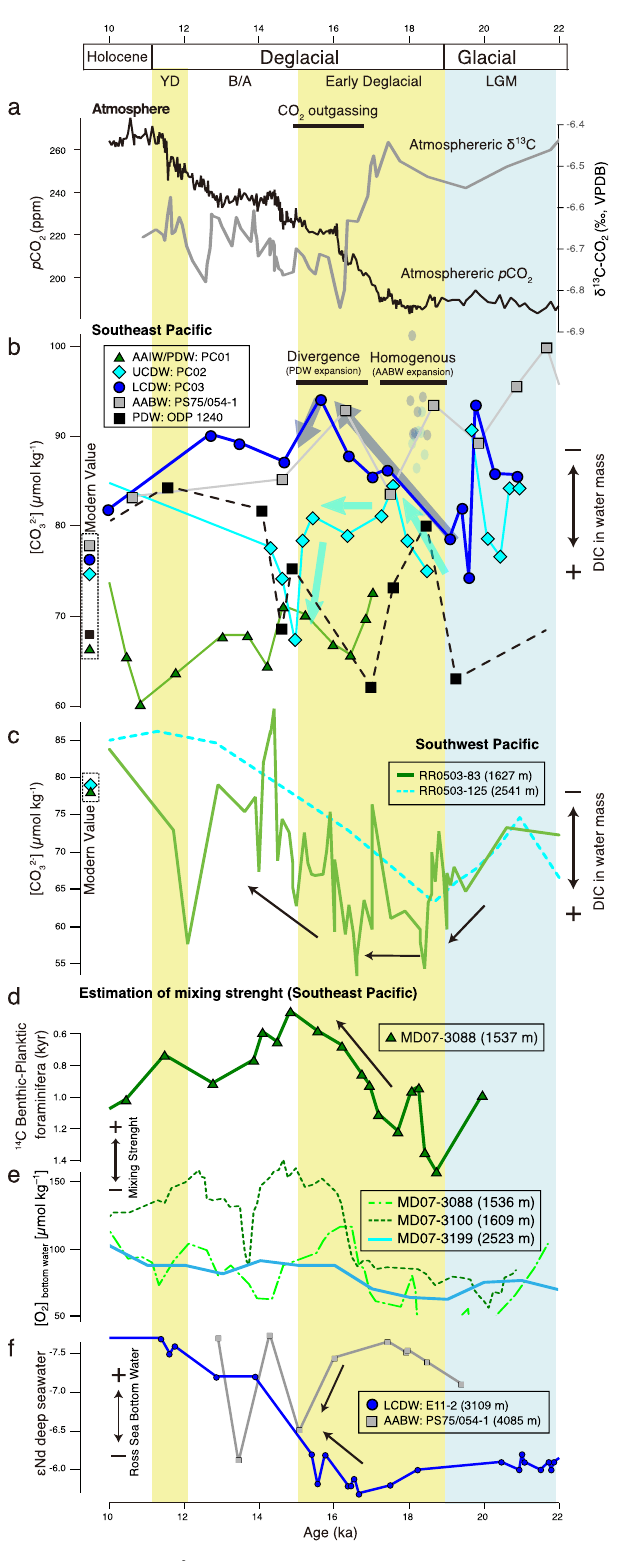
Fig.4|Deep-water[CO 3 2 − ]changeinstudyareacomparedtotherecordsinthe South Paci fi c. a Atmospheric CO 2 concentrations 70 , and atmospheric δ 13 C record from Antarctic ice cores 71 . b Deep-water [CO 3 2 − ] based on XMCT scanning method in the SE Paci fi c (this study) and result from ODP1240 from the Eastern equatorial Paci fi c 28 . c Deep-water [CO 3 2 − ] based on benthic foraminiferal B/Ca proxy in the SW Paci fi c 26,27 . d Changesintherecordsofforaminiferabenthic – planktic14CageintheSE Paci fi c 21 . e Changes in the records of bottom water oxygen concentration recon- struction in the SE Paci fi c 50 . f Change in ε Nd of deep water in the Southern Paci fi c 23 .